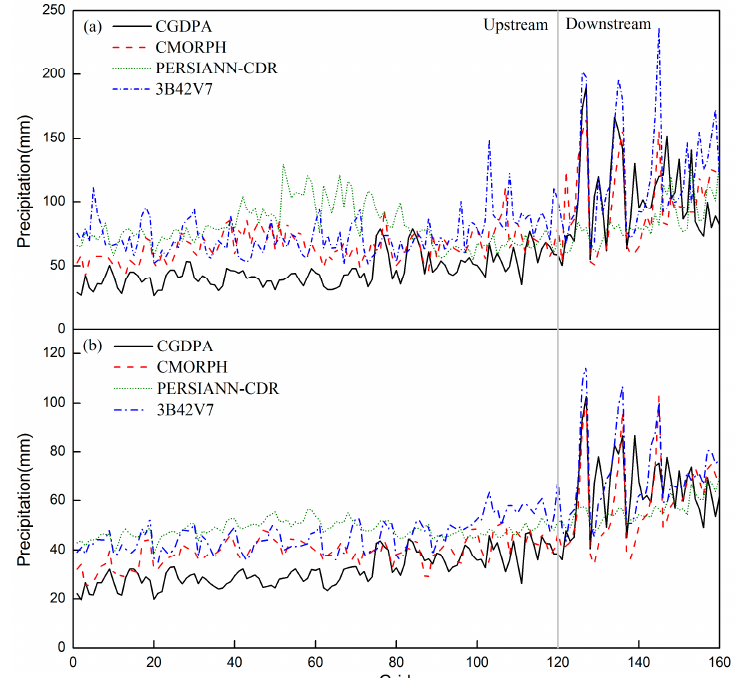
Figure 5. Spatial comparison of ( a ) the highest values and ( b ) the mean values of 16-year annual maximum daily precipitation at the whole basin. (Each grid in the basin is numbered with longitude increased from west to east and latitude decreased from north to south, among which grid 1–120 are defined as the upstream, the others as the downstream.).